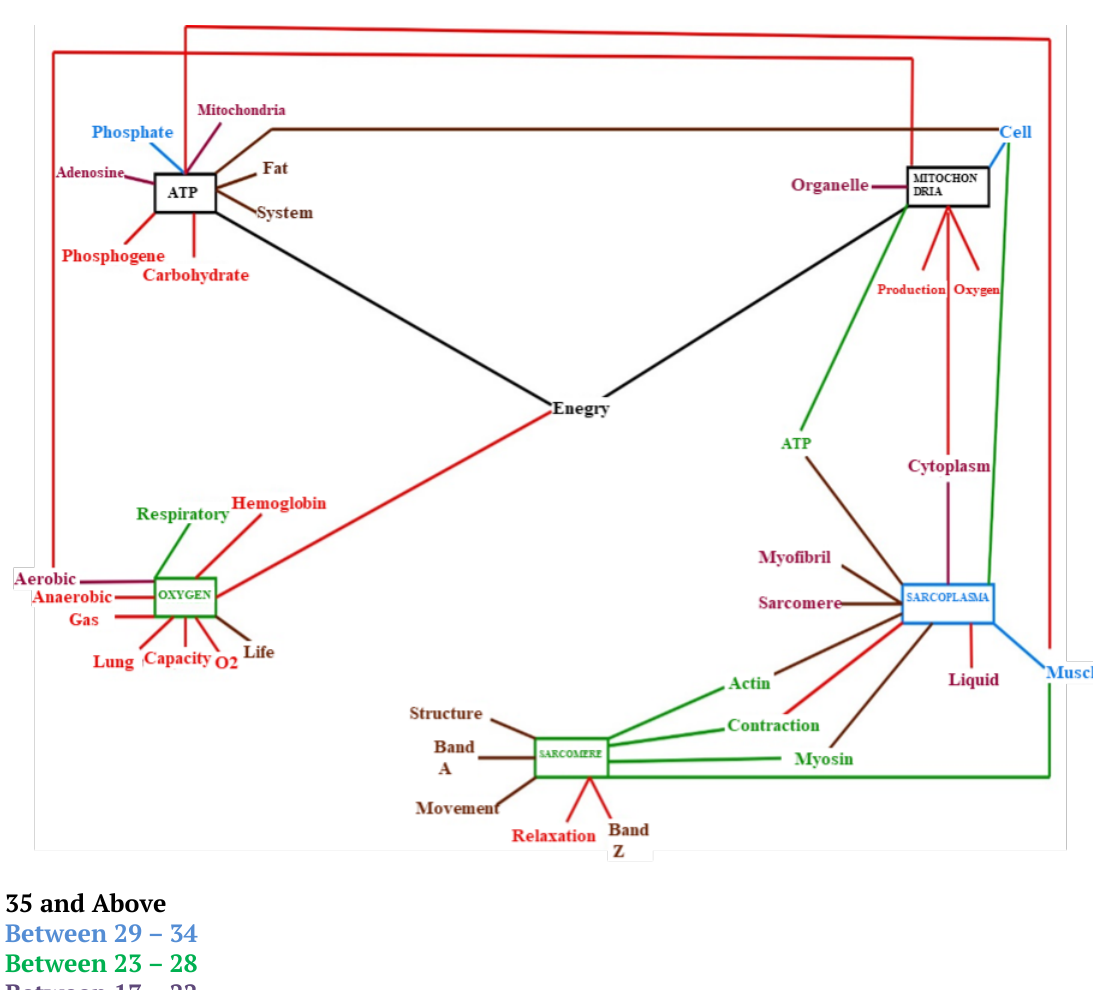
Figure 4. Concept Network Created by First Group Keywords (Post-Test) increases, it is seen in different studies that the level of association with other concepts also increases [14, 29]. The fact that students’ associating the answer words and key concepts with each other increased in the posttest, resulting in the formation of new and different concept networks (Figure 2- Figure